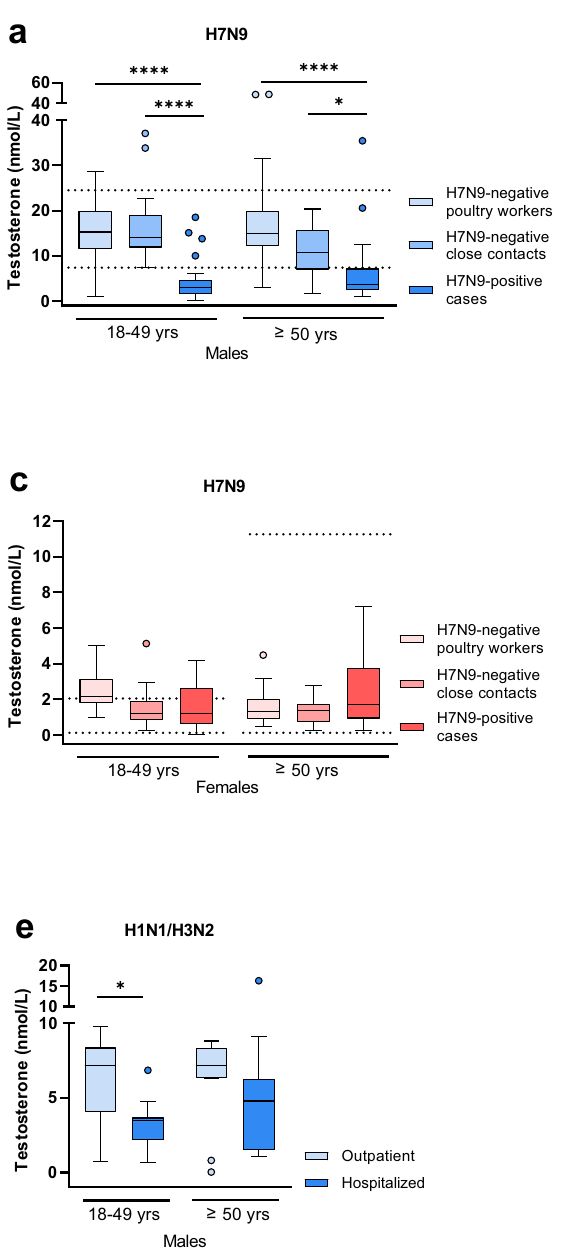
Fig. 1 | Testosterone levels in H7N9-infected patients compared to control cohorts. a Total testosterone expression levels were measured in sera from H7N9 IAV-infectedmalepatients(18 – 49yrs: n =33, ≥ 50yrs: n =38)andcomparedtomale controls as follows: (i) H7N9-negative poultry workers (18 – 49yrs: n =32, ≥ 50yrs: n =45) and (ii) H7N9-negative close contacts (18 – 49yrs: n =29, ≥ 50yrs: n=16).